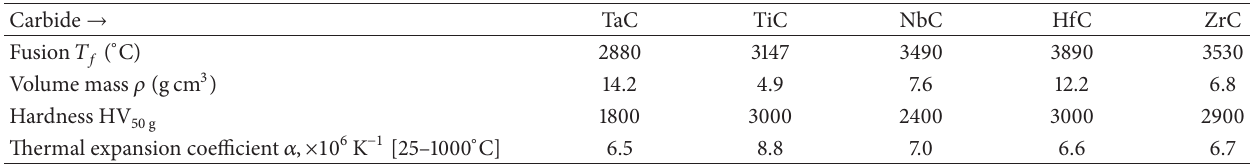
Table 1: Physical properties of different types of MC carbides.